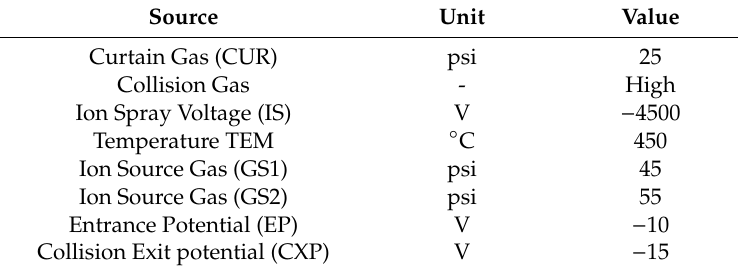
Table 1. Parameter used in ESI-MS / MS.